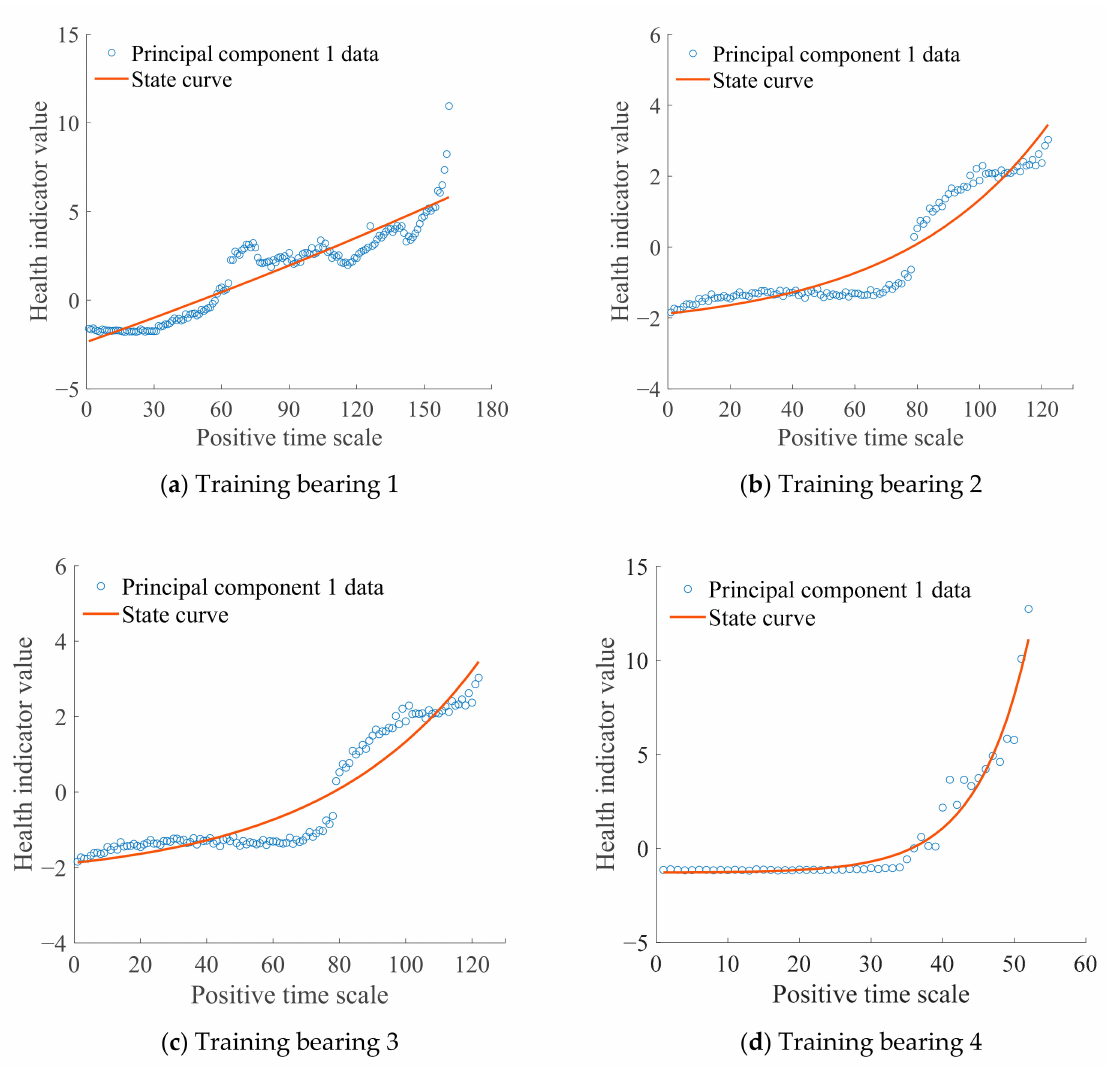
Figure 5. Training bearing state